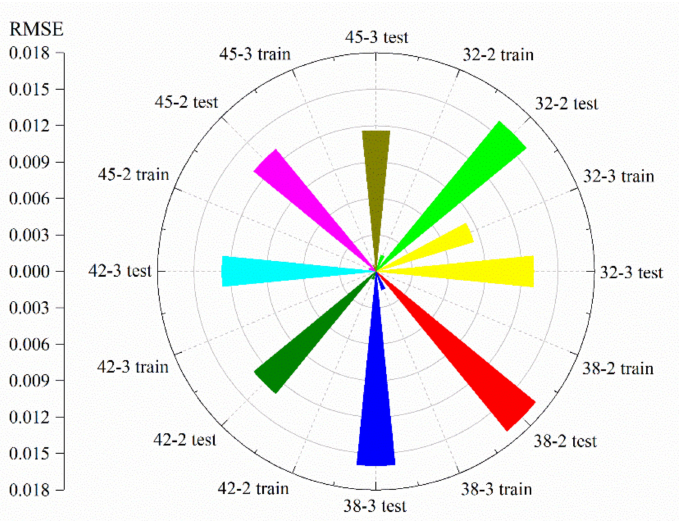
Figure 6. RMSE obtained from WOA-GPR with different samples and cycles for Case 1.